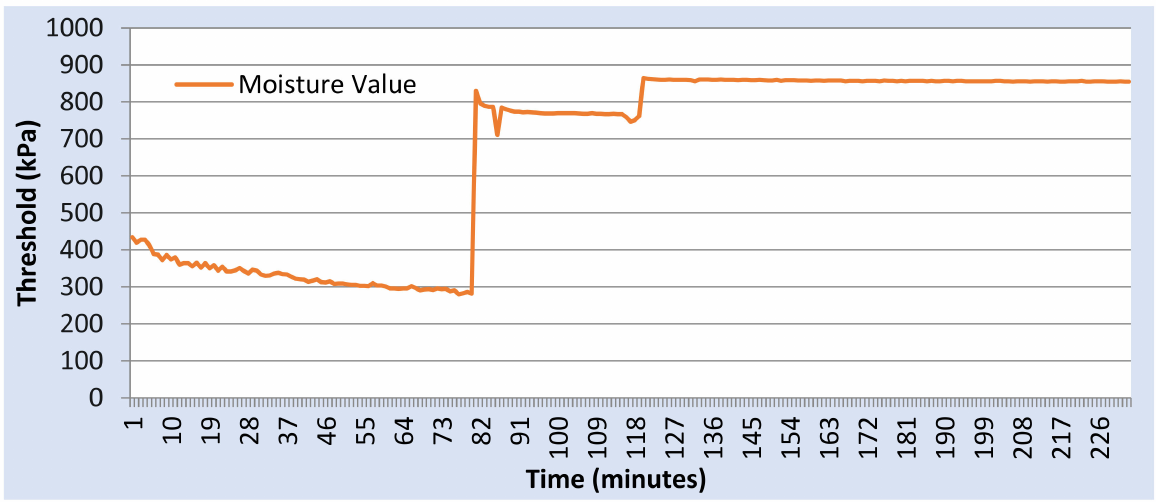
Figure 10. Measured soil moisture in the irrigation activity in Papaya test field by the sensor embedded in the